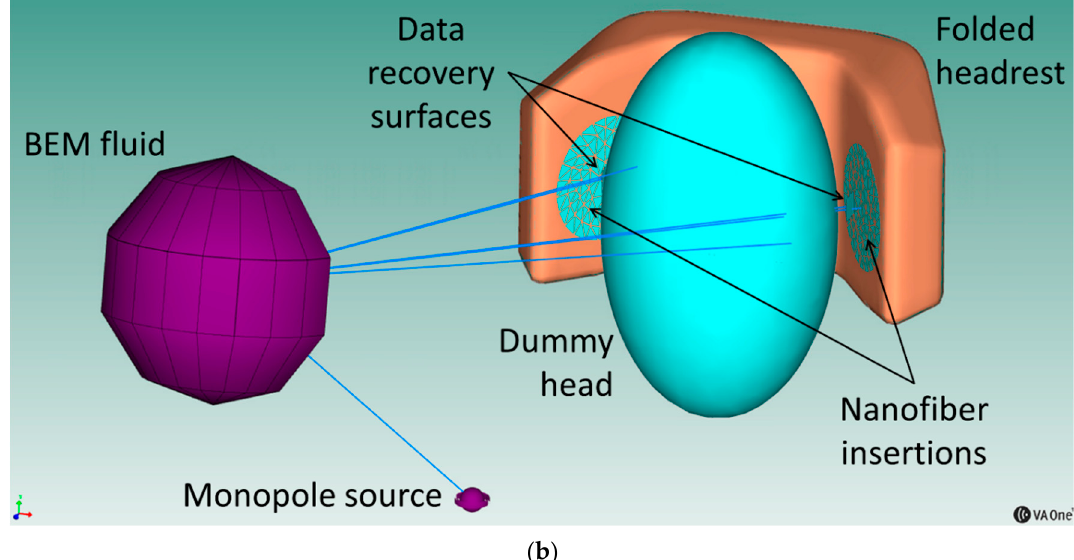
Figure 9. ( a ) BEM models; ( b ) close up of the model for the folded headrest and the monopole source positioned at 0°.